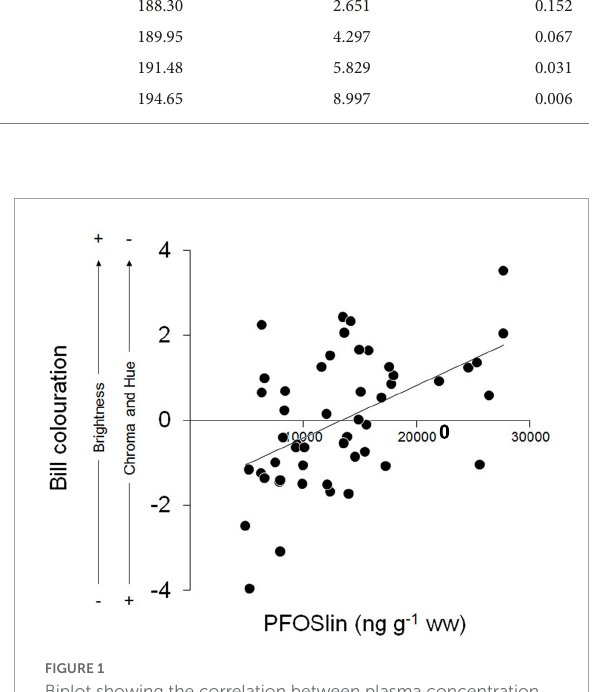
FIGURE1 Biplot showing the correlation between plasma concentration of PFOSlin and bill colouration (PC2 from PCA) in 50 Arctic male kittiwakes sampled during the pre-laying